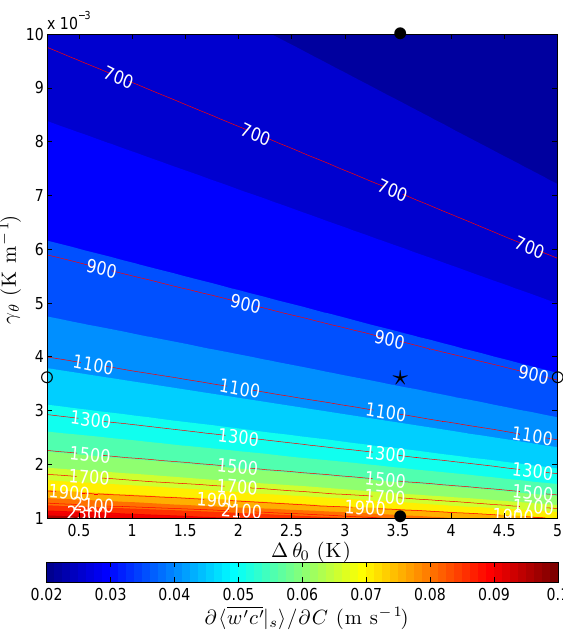
Fig.9. SameasFig. 6for ∂ h w ′ c ′ | s i /∂C . Fig. 9. Same as Fig. 6 for ∂ h w 0 c 0 | s i /∂C